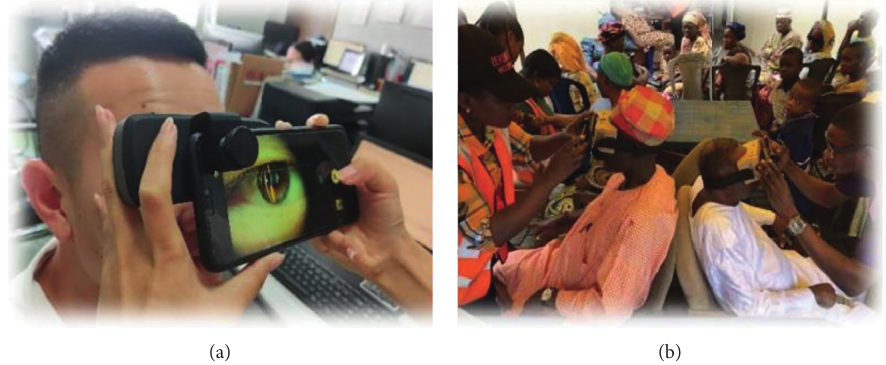
Figure 6: (a) Schematic diagram of slit-lamp use. (b) Screening of cataract diseases in Africa.